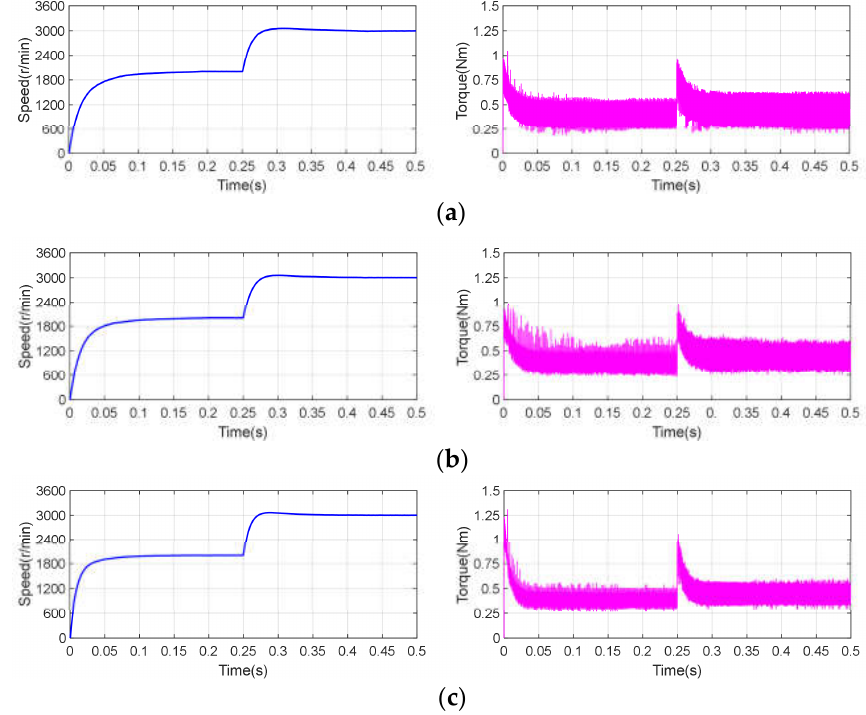
Figure 9. Experimental results under speed change. ( a ) PI, ( b ) SMC, and ( c ) proposed TSMC. Due to the small influence of parameter perturbation, the variable load torque is taken as one of the operating conditions to study the anti-disturbance ability. Figure 10 presents the speed and torque waveforms of PI, SMC, and the proposed TSMC in the DITC strategy when the load torque changes from 0.3 Nm to 0.5 Nm at 0.25 s under 3000 r/min. As shown, the speed overshoot of the proposed TSMC is 140 r/min, while those of PI and SMC are 363 r/min and 269 r/min, respectively. When the load torque changes at 0.25 s, three controllers take about 0.17 s, 0.15 s, and 0.11 s to reach the steady reference speed, respectively. The experimental results indicate that the proposed TSMC shows better anti-disturbance ability and robustness when an external disturbance occurs compared with PI and SMC. The torque ripple ranges in the steady state of PI, SMC, and proposed TSMC are 0.6 Nm, 0.47 Nm, and 0.37 Nm under 0.5 Nm, respectively. Among them, the torque ripple range of the proposed TSMC can be reduced by 38% and 21% compared